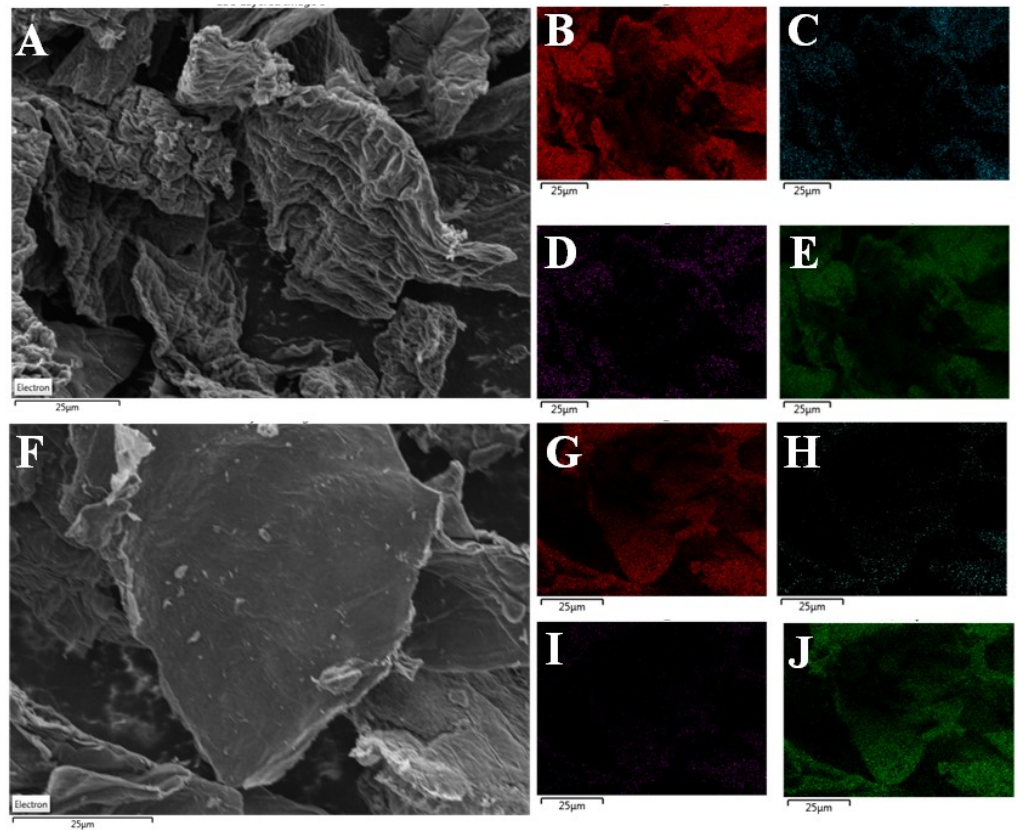
Figure 4. SEM-mapping micrographs of Pd-N/C a and Pd-N/C b materials. SEM images of Pd-N/C a ( A ) and Pd-N/C b ( F ). SEM-mapping results of Pd-N/C a for carbon ( B ), nitrogen ( C ), oxygen ( D ) and palladium ( E ). SEM-mapping results of Pd-N/C b for carbon ( G ), nitrogen ( H ), oxygen ( I ) and palladium ( J ).